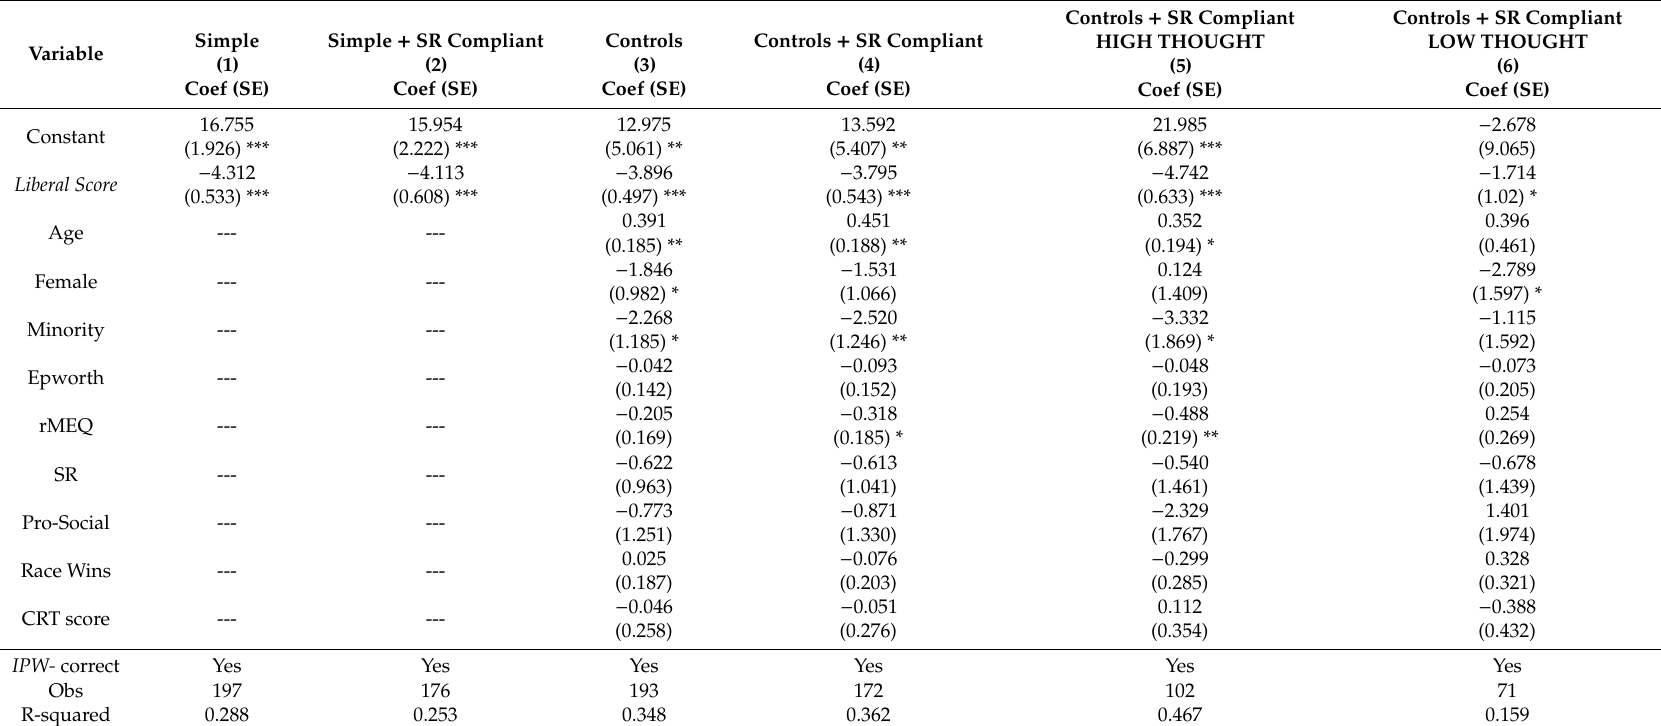
Table 3. Impact of Liberal Score on PRO-GUN-RIGHTS ARGUMENT STRENGTH—all